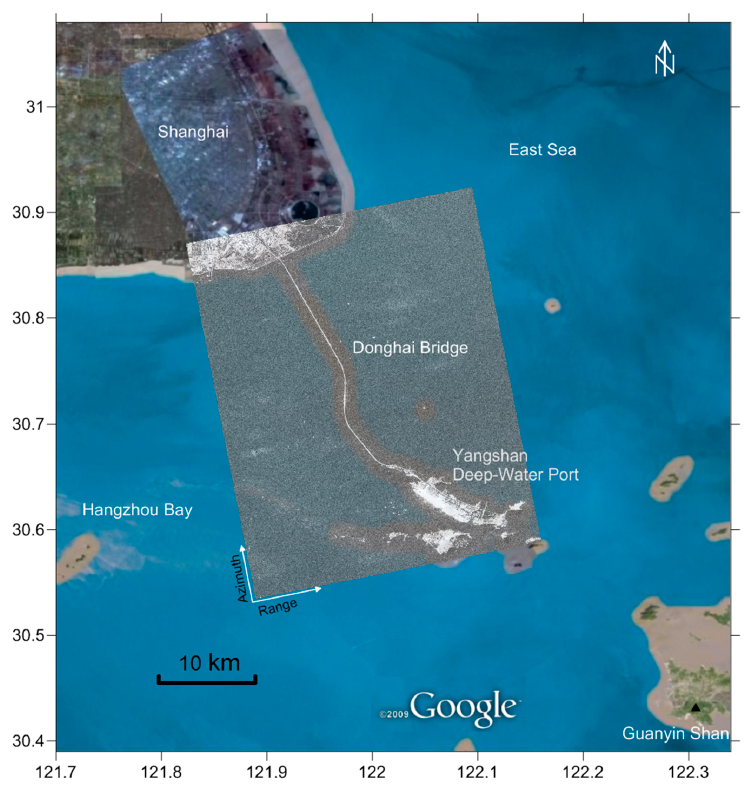
Figure 1. The location of the Donghai Bridge where a Phased Array type L-band Synthetic Aperture Radar (PALSAR) amplitude image was overlapped and the Google Maps image was taken as the background. The figure is plotted in the World Geodetic System (WGS) 84 coordinate system.